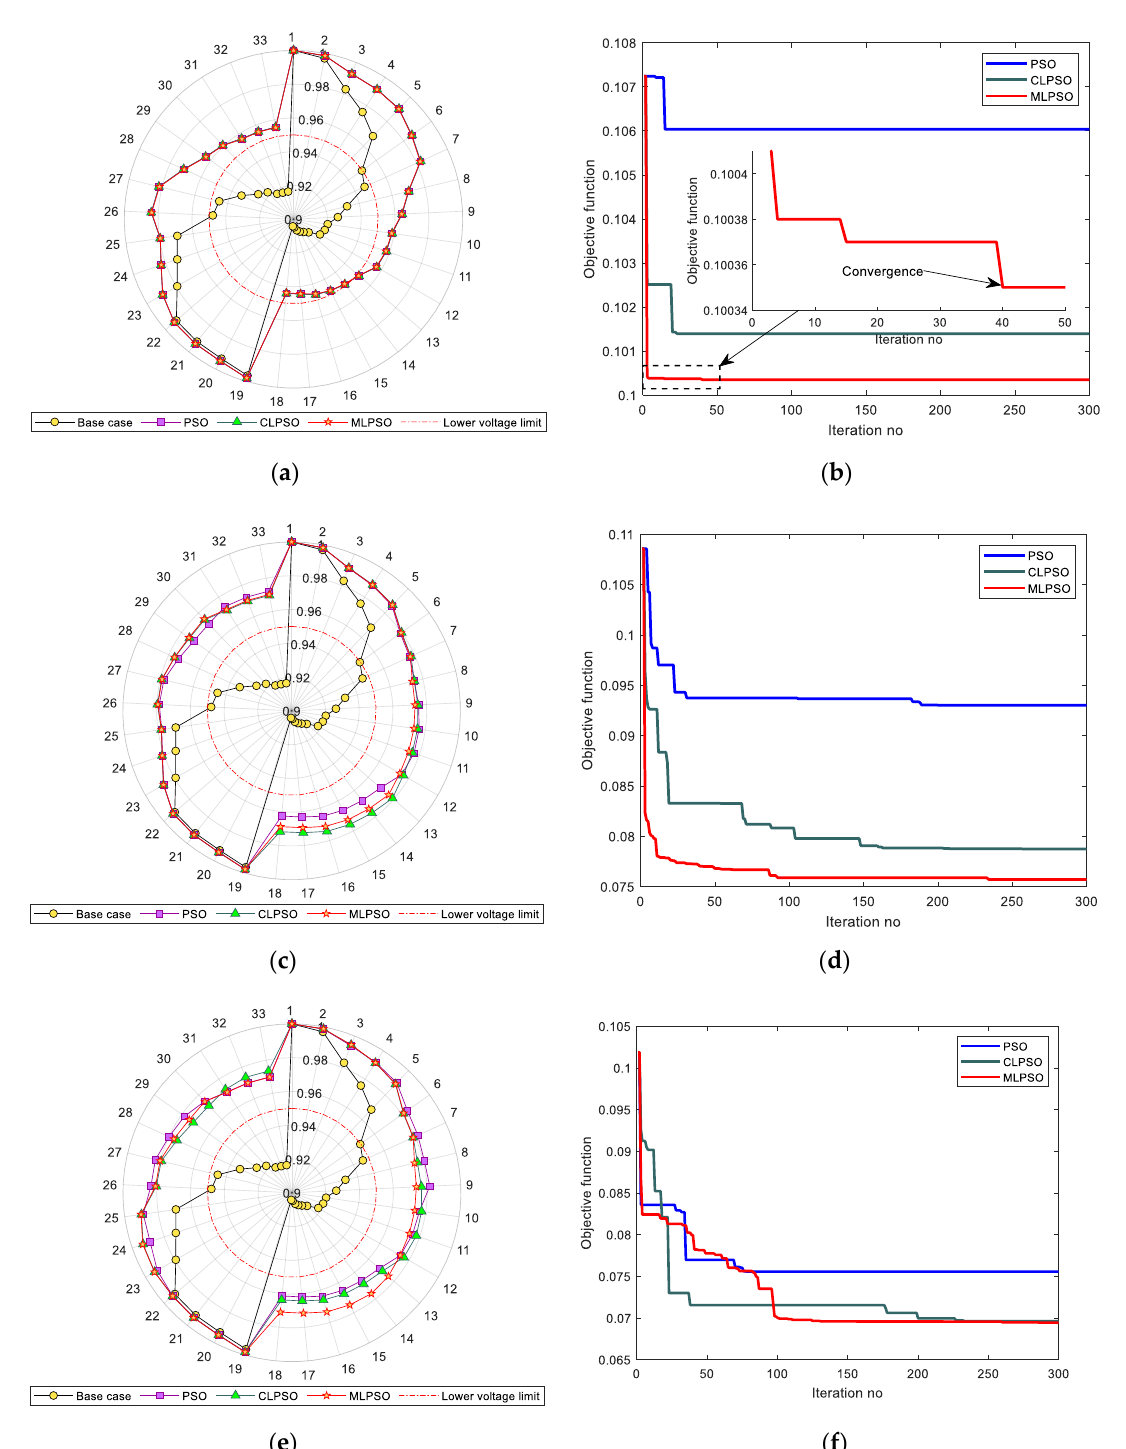
Figure 6. Variation of loss reduction with number of DGs for the IEEE 33 bus system.